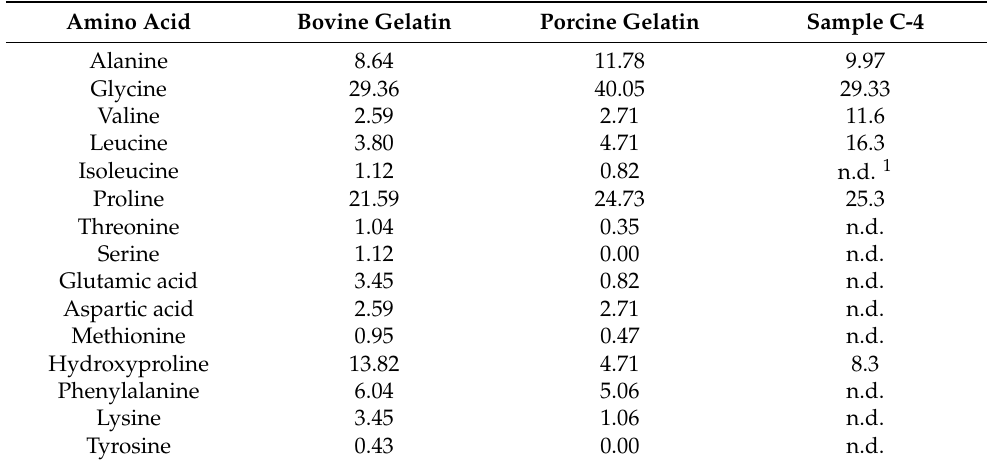
Table 3. Relative percentage of amino acids in porcine and bovine gelatin used as reference materials and the sample C-4